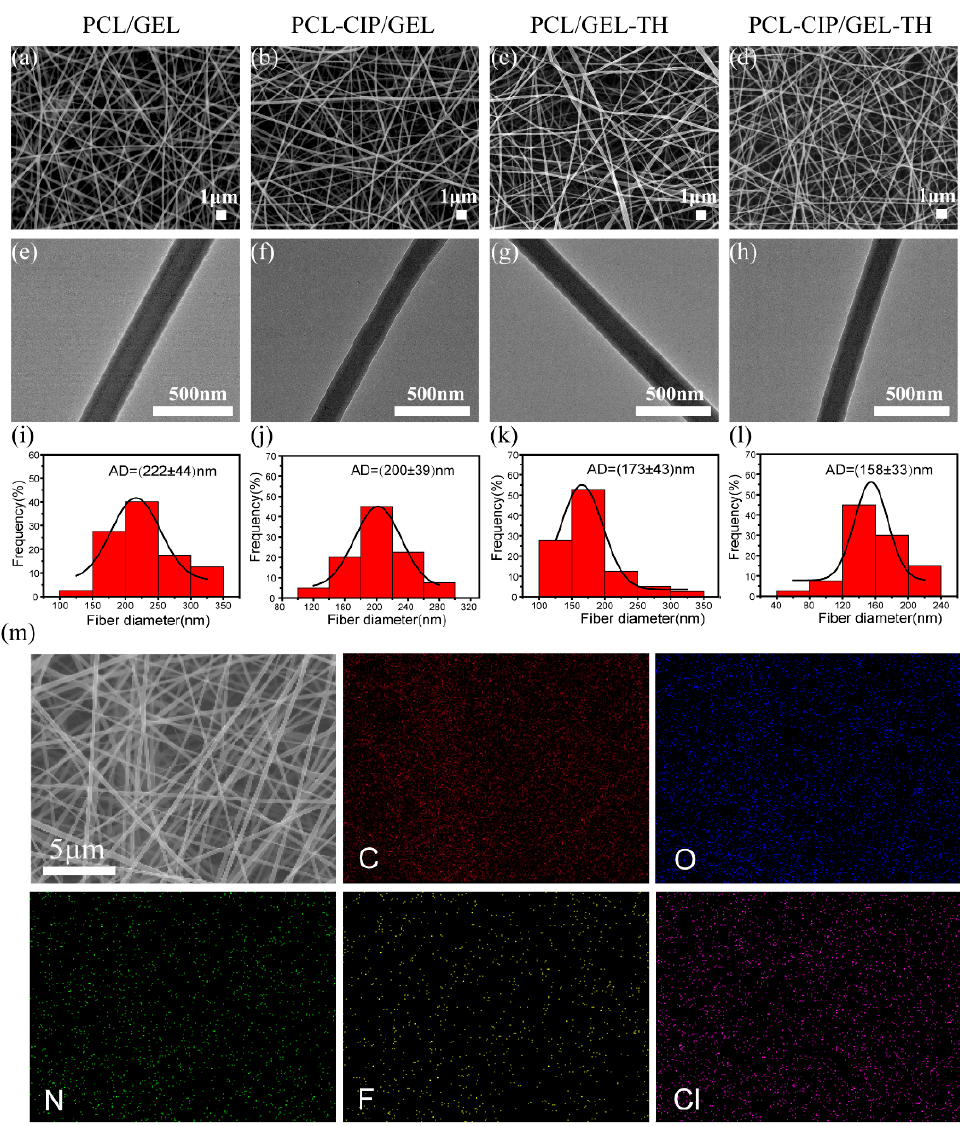
Figure 2. ( a – d ) SEM images of different coaxial nanofiber membranes; ( e – h ) TEM images of different core–shell nanofibers; ( i – l ) diameter distribution of different nanofibers; ( m ) EDS mapping of the PCL-CIP/GEL-TH nanofibers. PCL-CIP/GEL-TH